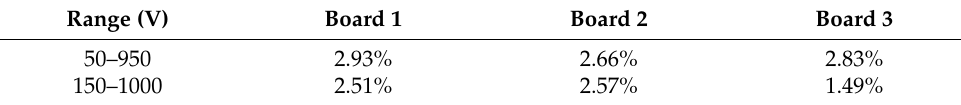
Table 3. Relative Error YHDC